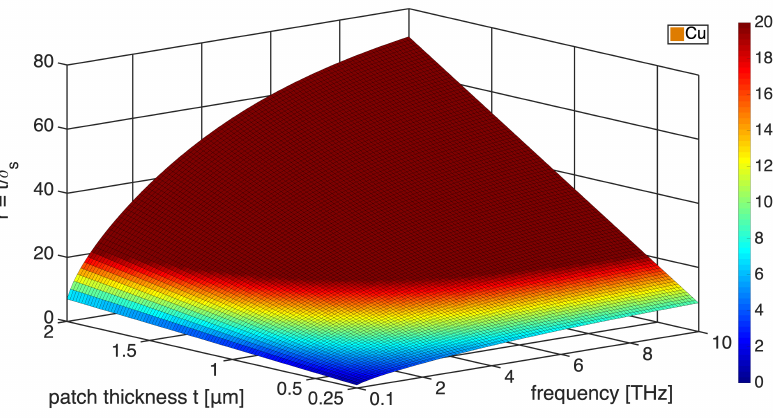
Figure 3. A 3 D representation of the ratio metal thickness to penetration depth r = t / δ s ( δ s : penetra- tion depth, t : thickness of metallic portions) for Cu at 0.1–10 THz frequency range. The color scale represents the values of the ratio r